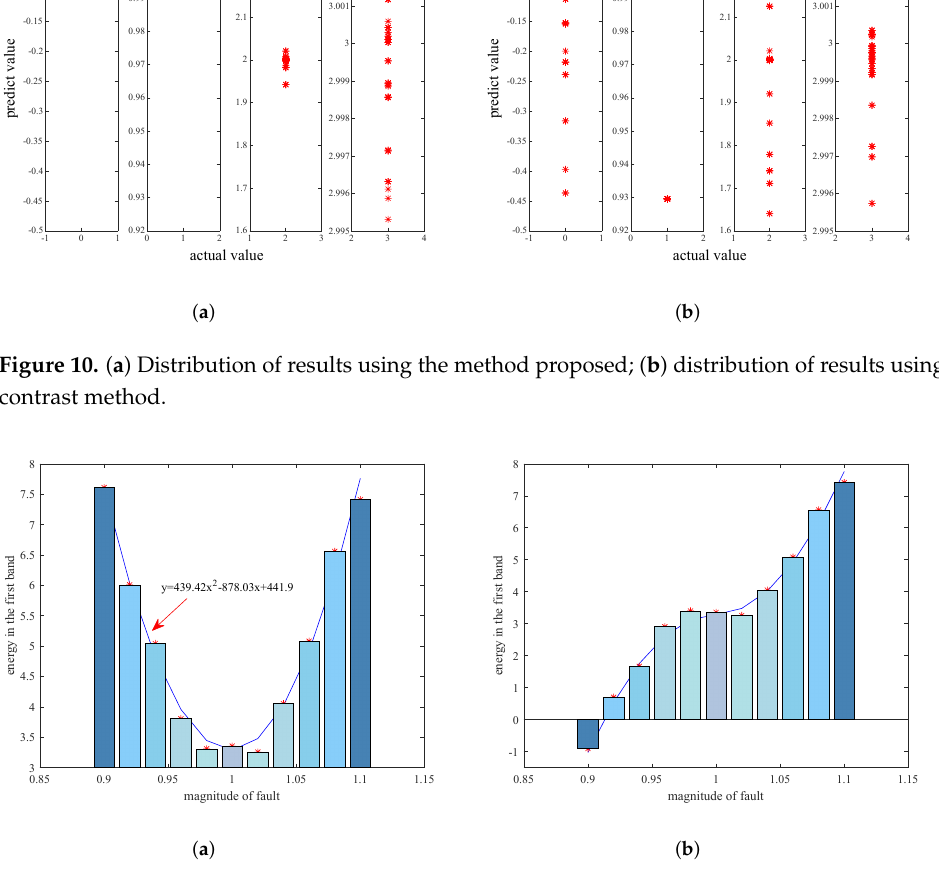
Figure 11. ( a ) Energy in the first band under different gain variation faults; ( b ) the relationship between the energy and the gain, considering the fault